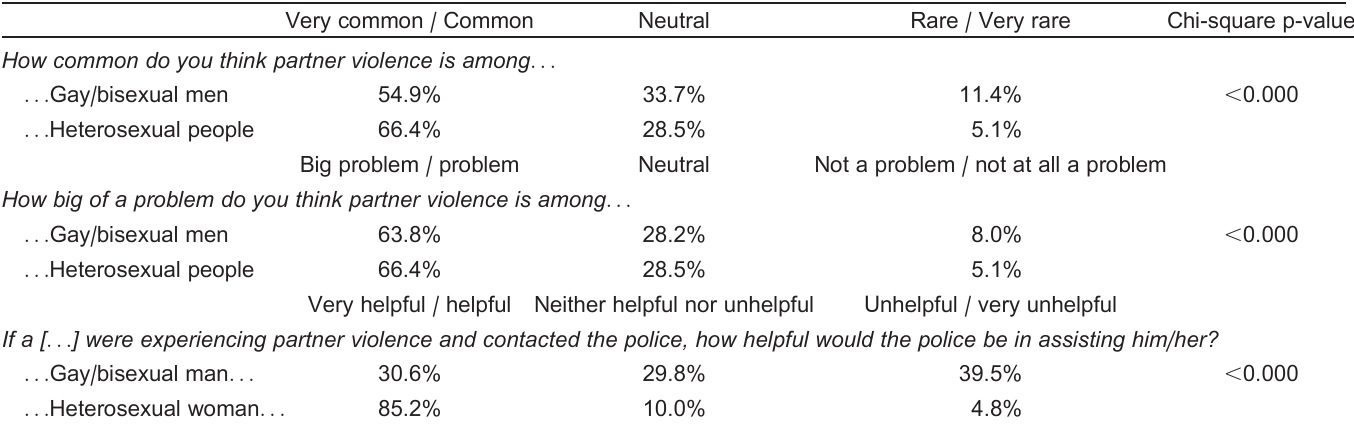
Table 2. Distribution of perceptions of the commonness, severity, and helpfulness of a hypothetical police response for both gay/bisexual men and heterosexual women.